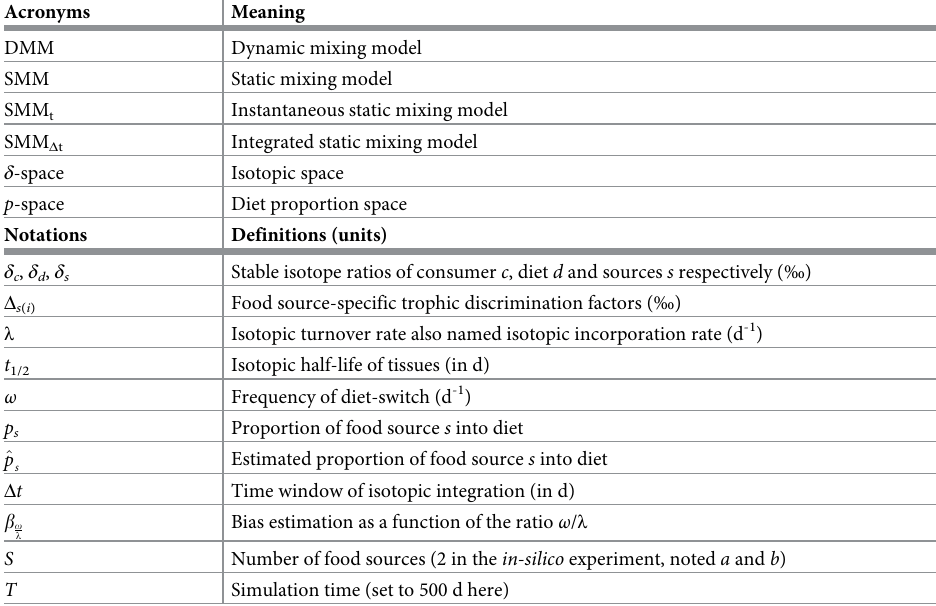
Table 1. List of acronyms and notations